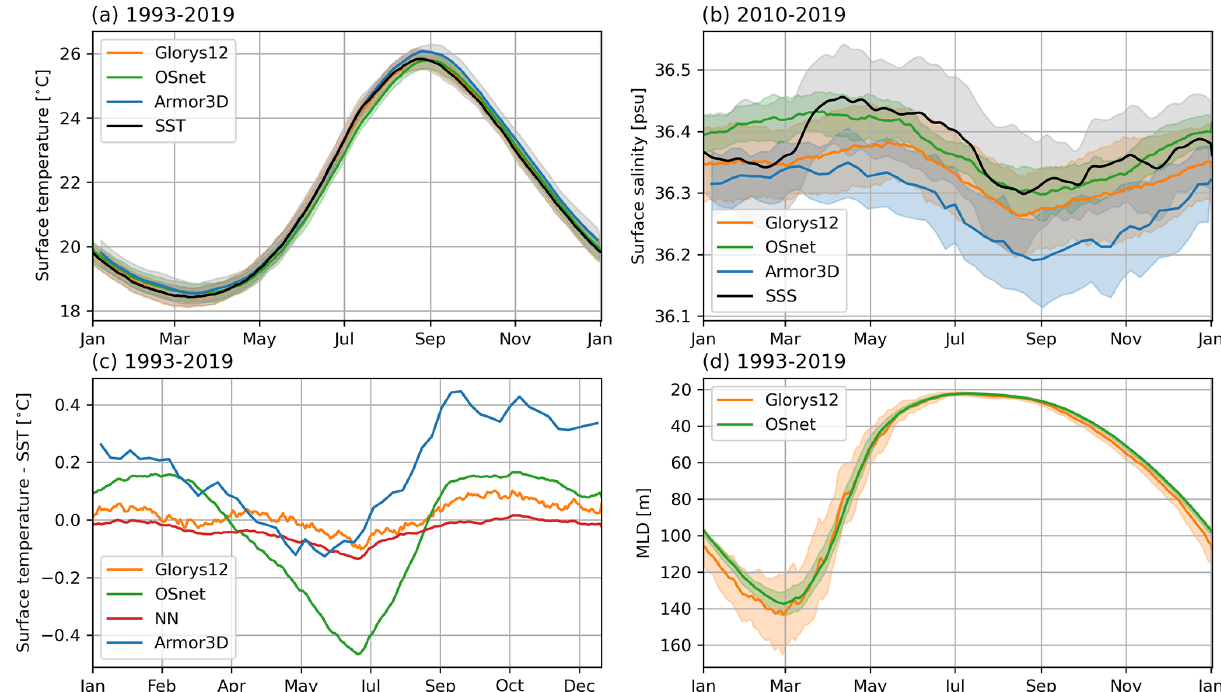
Figure 13. Seasonal variation of the mean surface temperature (a) , surface salinity (b) and MLD (d) for OSnet, Armor3D and Glorys12 compared to remote sensing SST and SSS (black). The difference between SST and the surface temperature is displayed in panel (c) , with the direct prediction of the NN hence without MLD adjustment in red. It is averaged over the period 1993–2019 excluding the shelf shallower than 1000m, except for the surface salinity because SSS only ranges from 2010 to 2019. The bands or errors are the standard deviation over the time